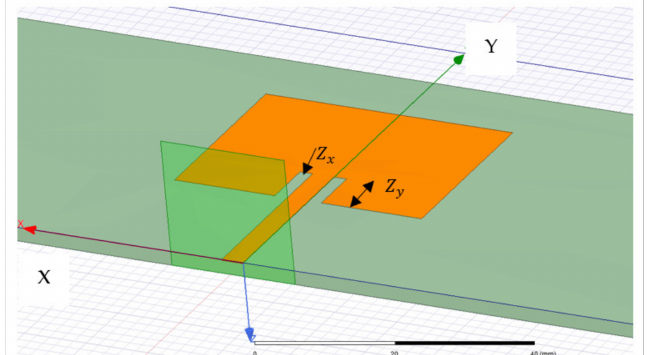
Figure 5. Layout of the embedded patch, GMS EP-280 S-Glass coupon and the waveport used to collect the RF response of the patch.